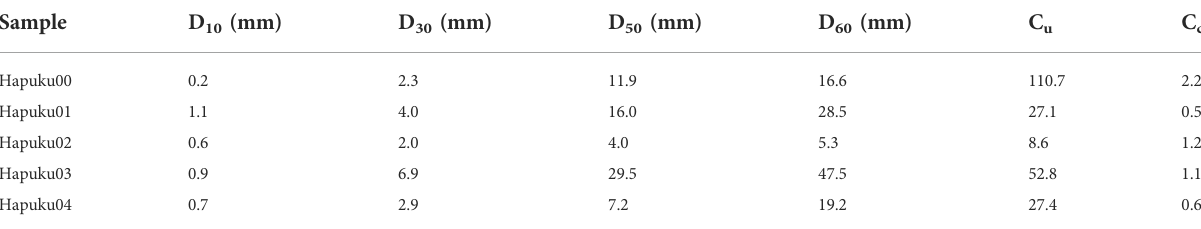
TABLE 2 Summary of PSD curves for the fi ve samples analysed at the HRA. D XX is the particle diameter at which XX% of the sample is fi ner. C u is the coef fi cient of uniformity and C c is the coef fi cient of curvature.